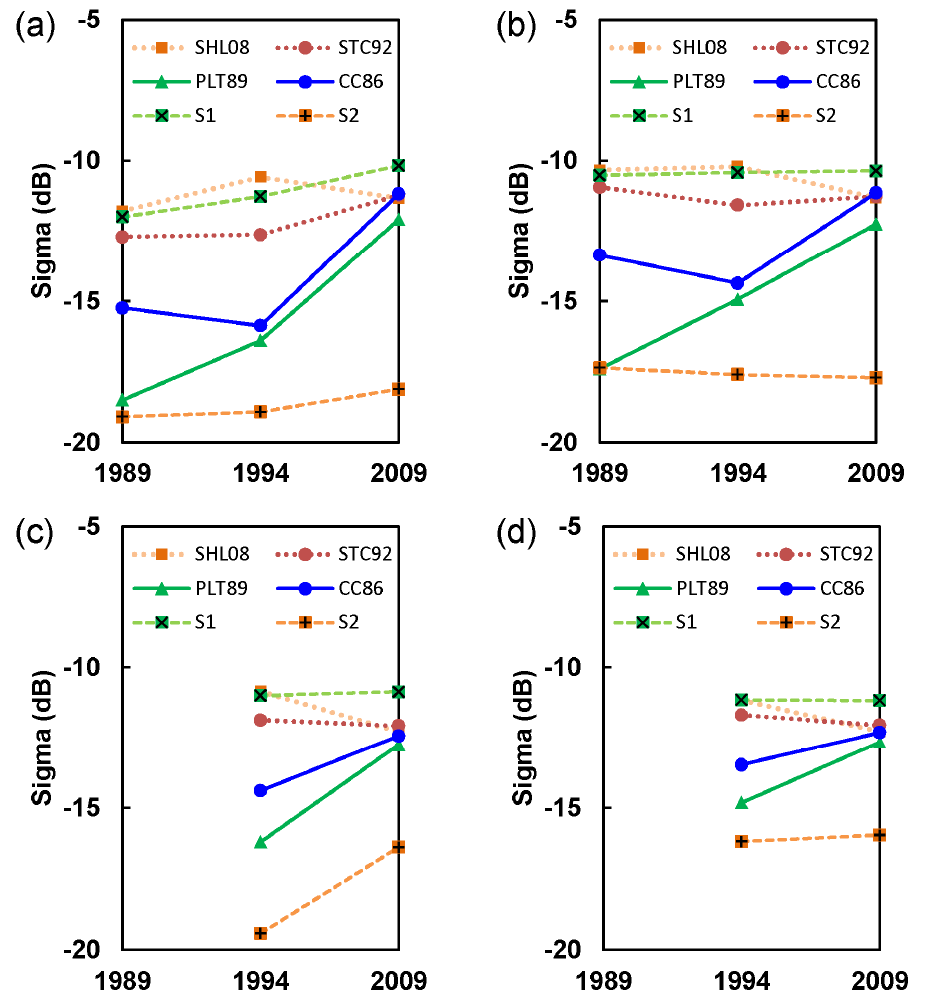
Figure 9. Changes in SAR backscatter (HV) from 1989–2009 at represented plots ( a – d ). (a,c) are values before and after normalization from the airborne data (AIRSAR 2 September 1989, 7 October 1994, and UAVSAR 5 August 2009), while (b,d) are values from the spaceborne data (SIR-C/XSAR 4 October 1994, and PALSAR 30 August